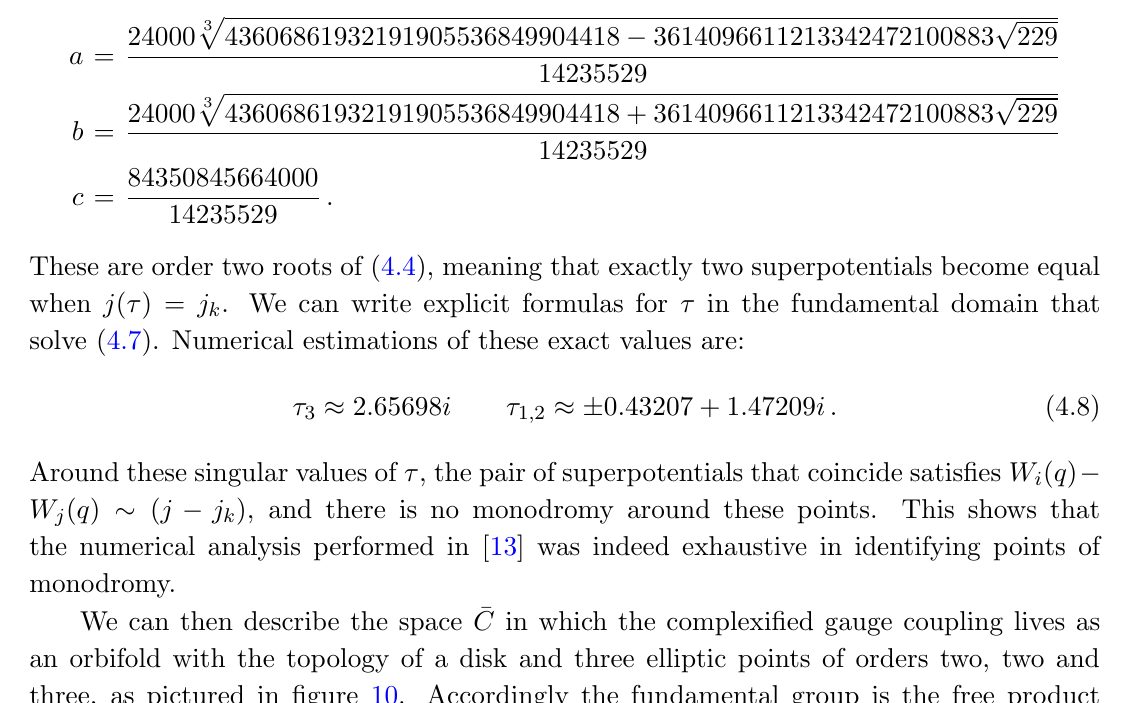
Figure 10 . The orbifold (cid:22) C for the N = 1 (cid:3) theory with gauge algebra so (8). where (cid:22) = exp(2 (cid:25)i= 3) and k = 1 ; 2 ; 3 and a , b and c are the real